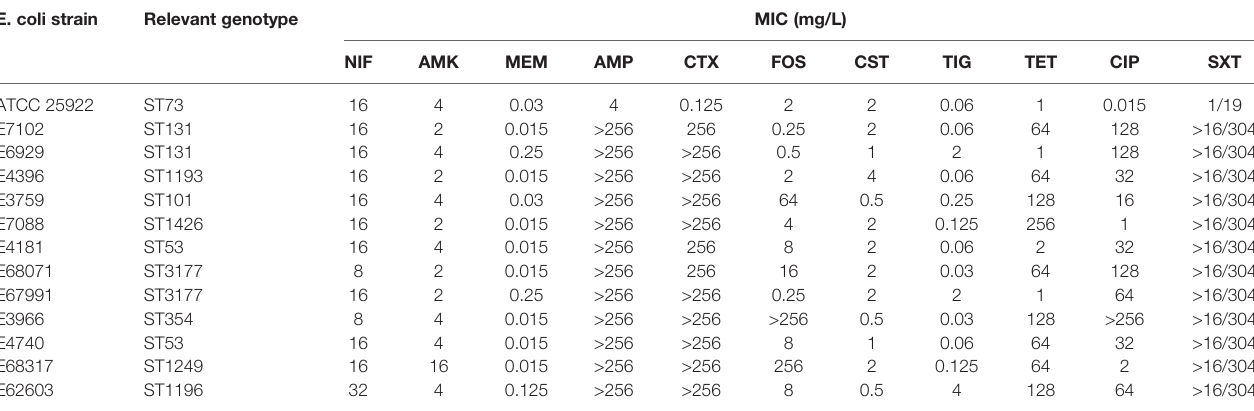
TABLE 1 | In vitro antimicrobial susceptibility pro fi les for clinical